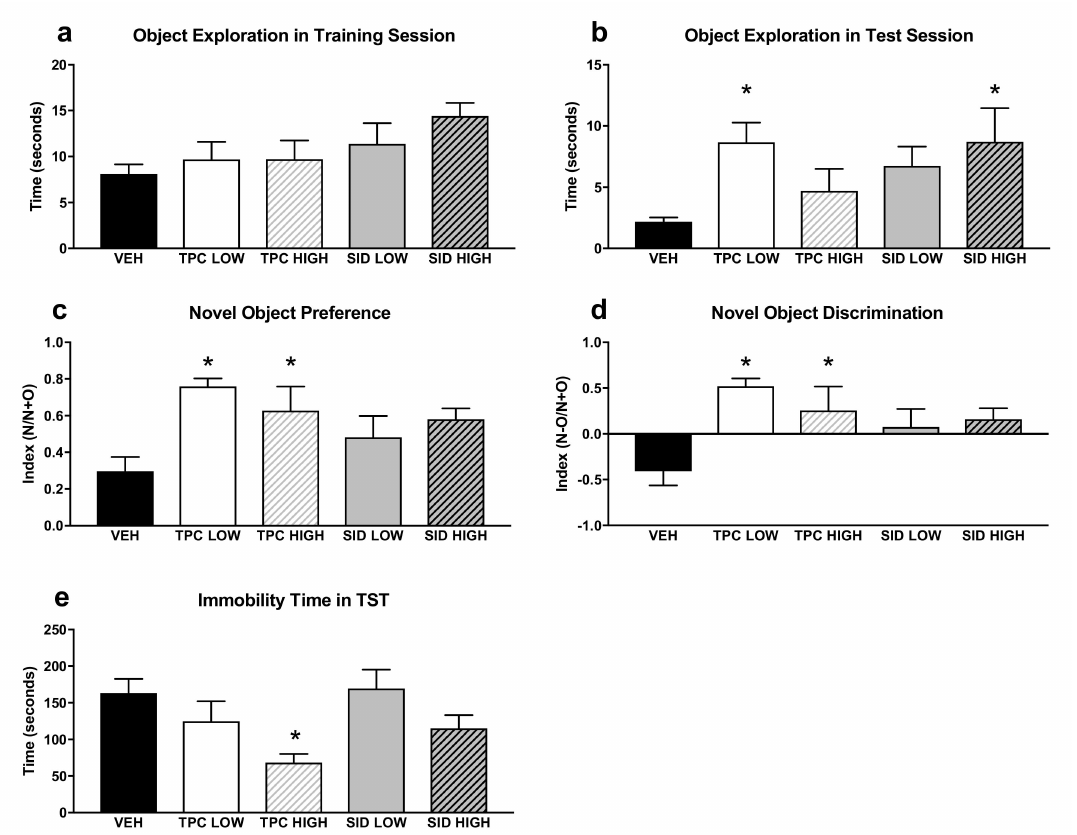
Figure 3. Novel Object Recognition test (NOR) and Tail Suspension Test (TST). ( a ) Total time of object exploration in the first training NOR session. ( b ) Total time of exploration in the second NOR test session. ( c ) Preference index for the new object in the second NOR test session, calculated as N / (N + O), where N = new object and O = old object. ( d ) Discrimination index in the second NOR test session, calculated as (N-O) / (N + O). ( e ) Immobility time in the TST, calculated by the automated algorithm (see Methods). TPC Low Dose = 10 mg / kg, High Dose = 30 mg / kg, SID Low Dose = 50 mg / kg,